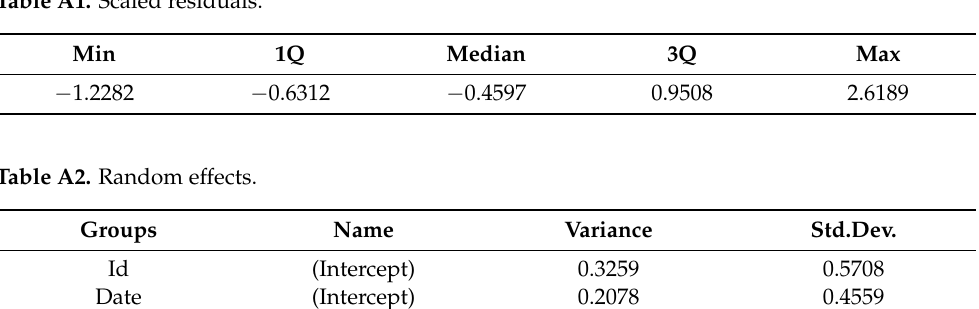
Table A1. Scaled residuals.